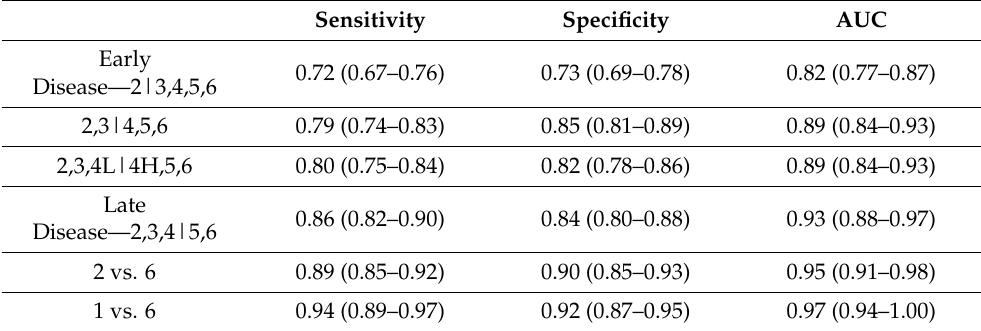
Table 1. Diagnostic accuracy of predictive models for OED/OSCC. Dichotomous splits for case vs. non-case are indicated by “|”. Sensitivity, specificity, and AUC (95% CIs) for the cross- validated algorithms for early disease (2|3,4,5,6), mild|moderate dysplasia (2,3|4,5,6), low|high risk (2,3,4L|4H,5,6), late disease (2,3,4|5,6), benign vs. malignant (2 vs. 6), and healthy control vs. malignant (1 vs. 6) models. Reproduced from [13] with permission from SAGE